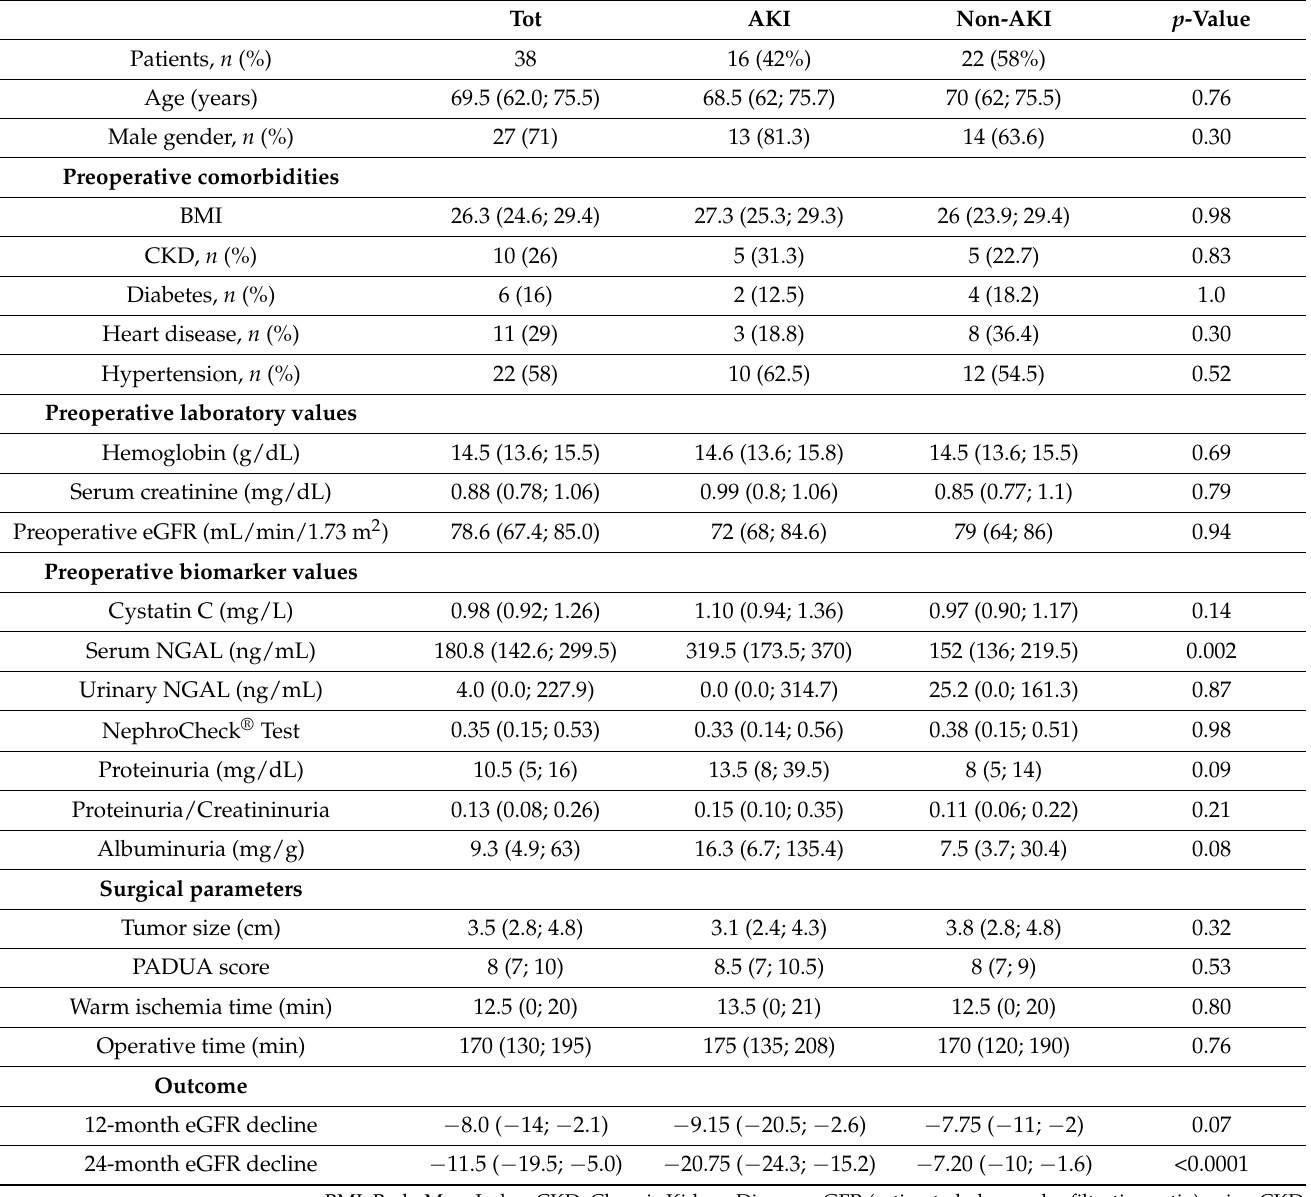
BMI, Body Mass Index, CKD, Chronic Kidney Disease, eGFR (estimated glomerular filtration ratio) using CKD- EPI formula and it is expressed in mL/min/1.73 m 2 , PADUA, Preoperative Aspects and Dimensions Used for an Anatomical (PADUA) classification of renal tumors in patients who are candidates for nephron-sparing surgery. In accordance with KDIGO guidelines, CKD was defined as GFRcr < 60 mL/min/1.73 m 2 and/or persistent